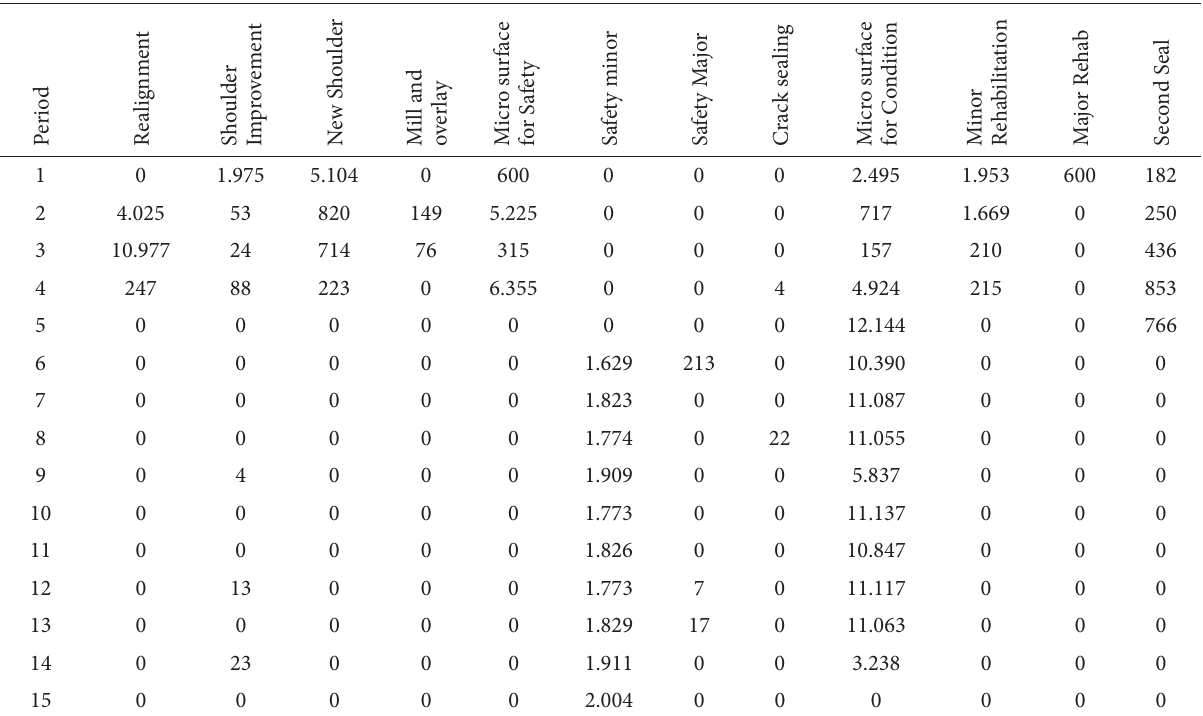
table 5. Investment allocation 8.5 mln EUR – Scenario B (in thousands of